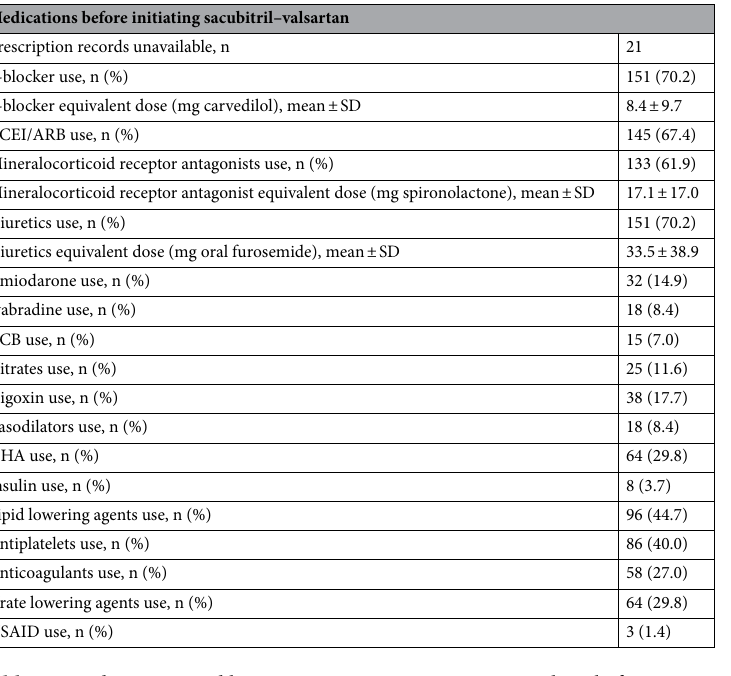
Table 3. Medications used by patients in anemia treatment analysis before initiating sacubitril–valsartan ( n = 236). ACEI angiotensin-converting enzyme inhibitors, ARB angiotensin receptor blocker, CCB calcium channel blockers, NSAID nonsteroidal anti-inflammatory agents, OHA oral hyperglycemic